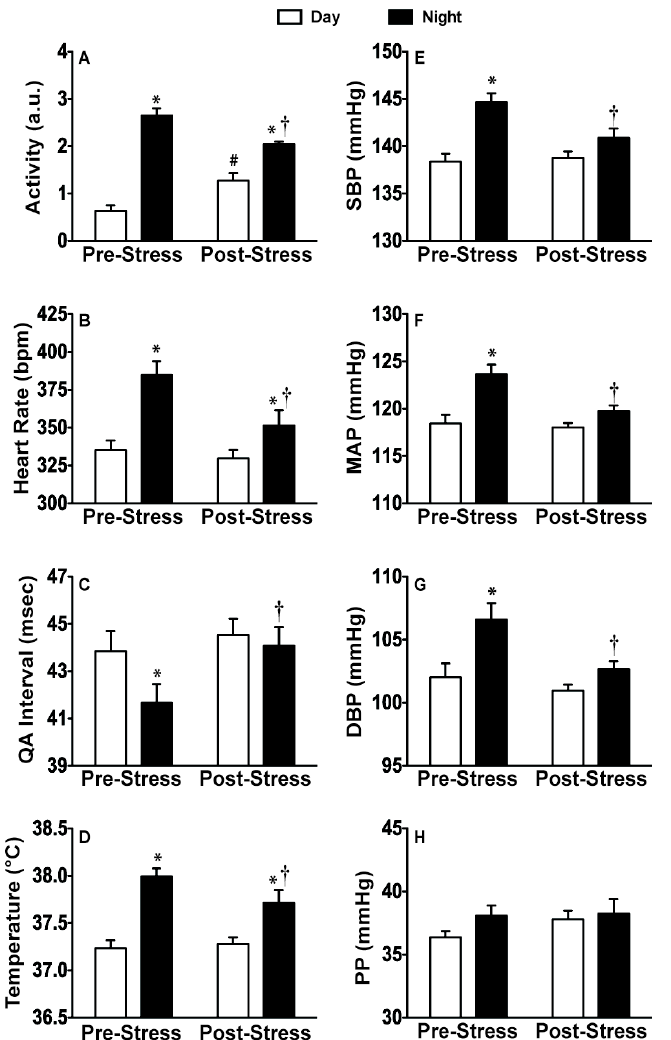
Figure 8. Flattening of diurnal rhythm. Day/night averages both pre-stress and post-stress demonstrating significant reductions in diurnal variation in measured variables